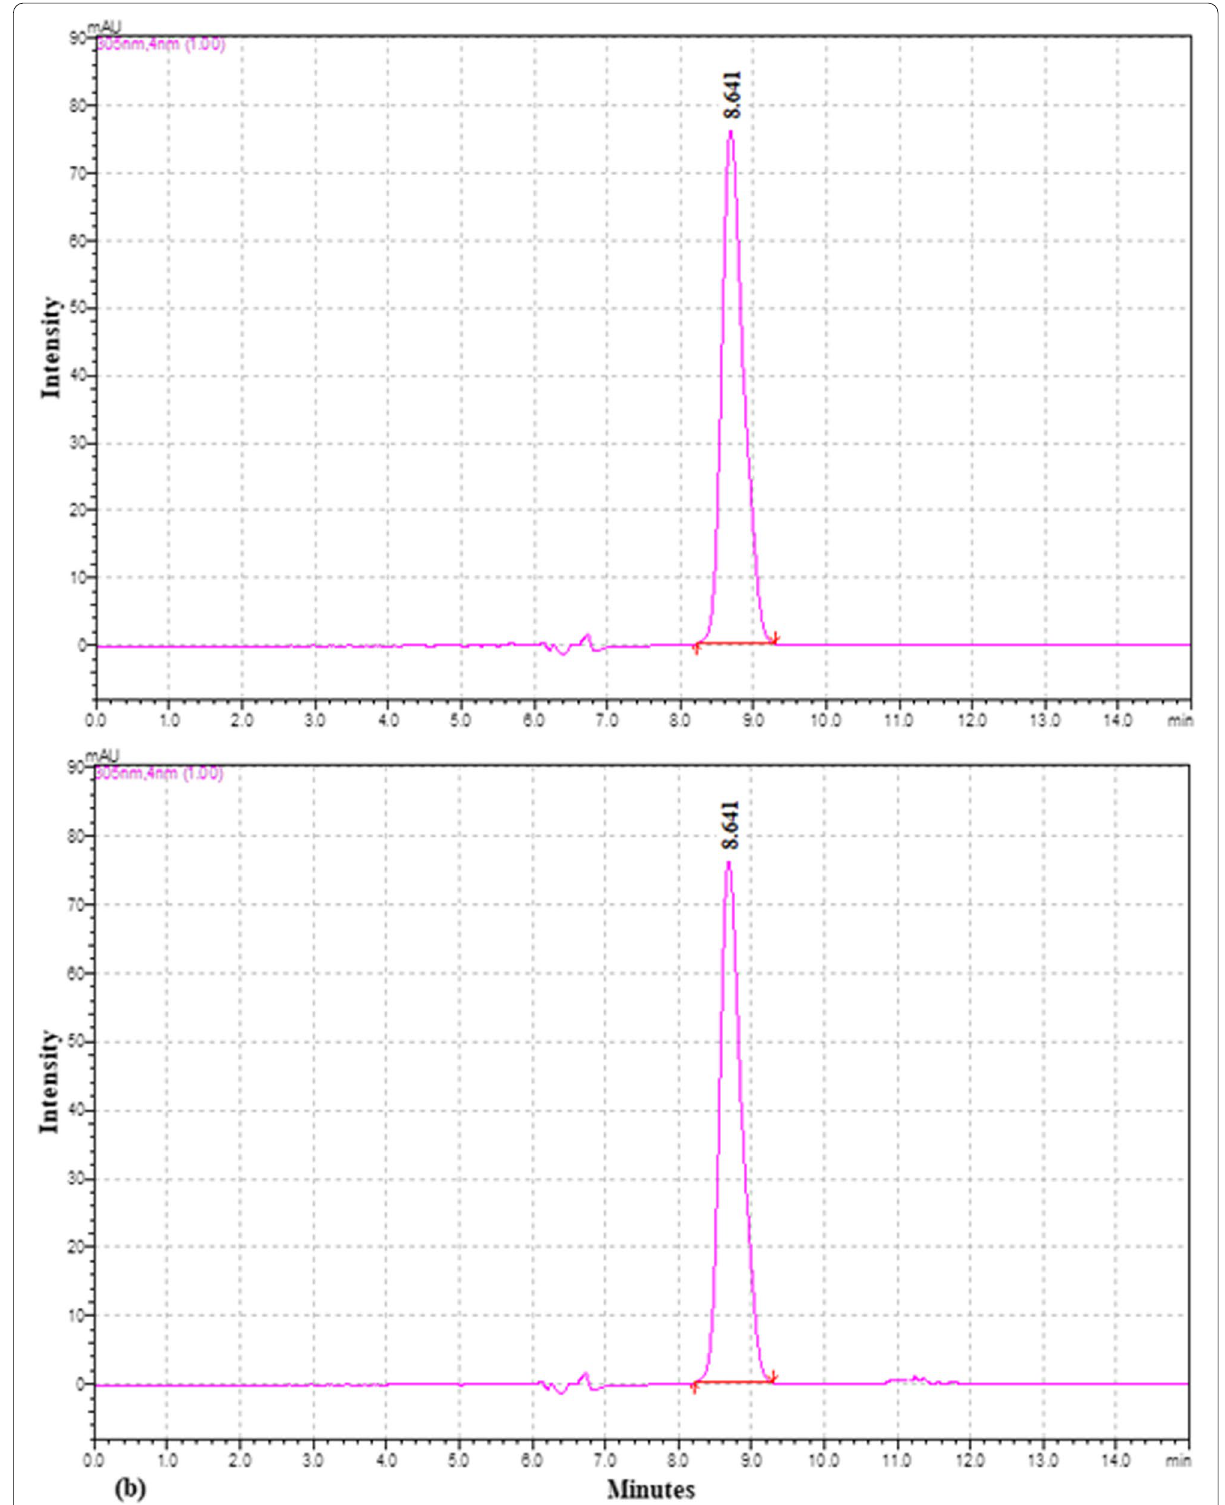
Fig. 2 A typical chromatogram showing standard solution ( a ) and sample solution ( b ) of